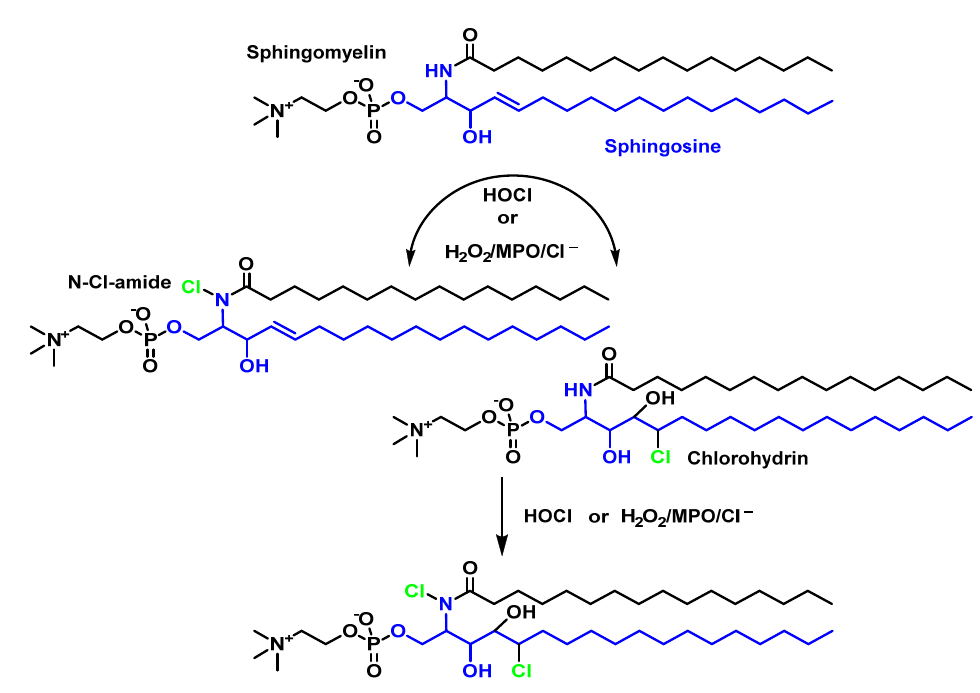
Figure 12. Sphingomyelin modification by HOCl or H 2 O 2 /MPO/Cl − . Chlorinated sphingomyelin derivatives produce significant deleterious effects on cells, including apoptosis and DNA damage.